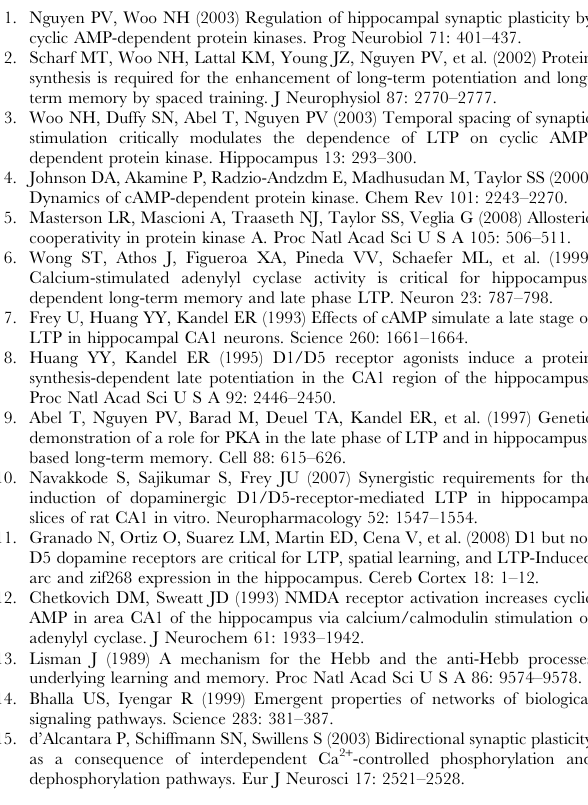
Figure S4 Effect of additional calmodulin on PKA and CaMKII activity. (A) Without additional calmodulin, subsequent stimula- tion trains produce a smaller increment in phosphoCaMKII. With added calmodulin, increased phosphorylation leads to an increased rate of subsequent phosphorylation, because phosphor- ylated CaMKII has higher activity than unphosphorylated CaMKII (Fig S4A). This response of CaMKII with added calmodulin (increasing increments with subsequent stimulation trains) is consistent with the positive feedback loop implicit in a widely accepted conceptual model of CaMKII activation. (B) The incorporation of additional calmodulin does not change the main result, namely that PKA cumulative activity is higher with spaced